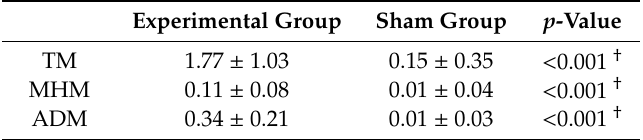
Table 3. Comparison of improvement after treatment in each